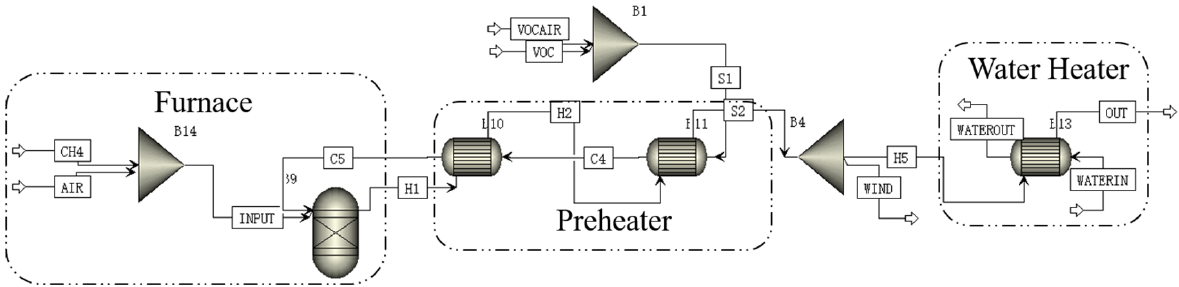
Figure 2. Flow diagram of the thermal conversion of VOCs.